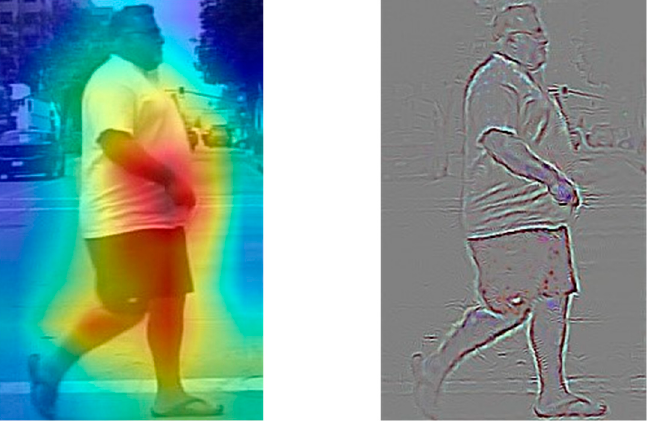
Figure 8. The left figure is a heat map of the pedestrian. The figure on the right shows the gradient diagram for a pedestrian. The two figures show that the intensity of the contribution of pedestrian features decreases from the center to the surroundings.